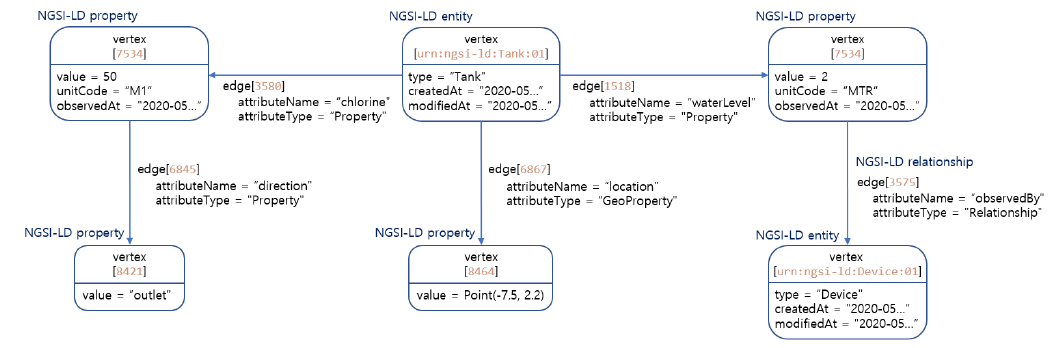
Figure 7. Mapping Tank Entity to Graph